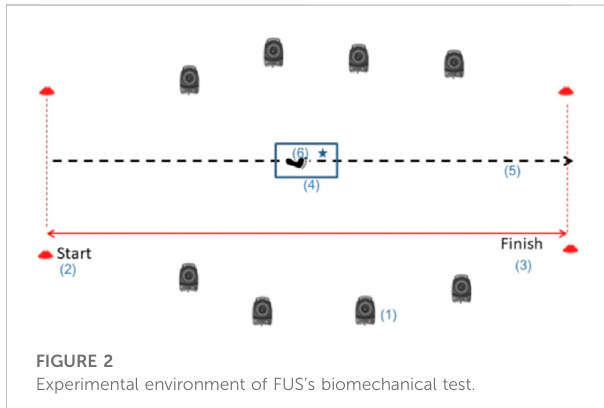
Experimental environment of FUS ’ s biomechanical